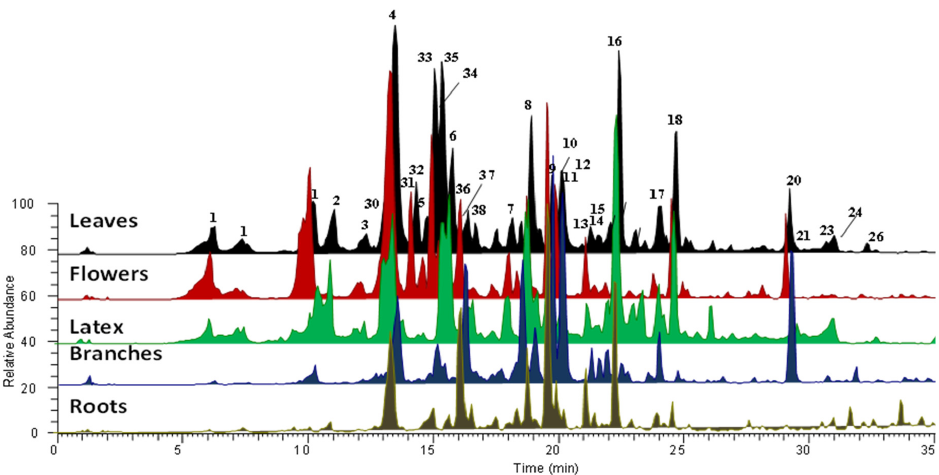
Figure 2. Extracted ion chromatograms, registered in positive ion mode, of methanolic extracts of different organs and latex of C. procera.